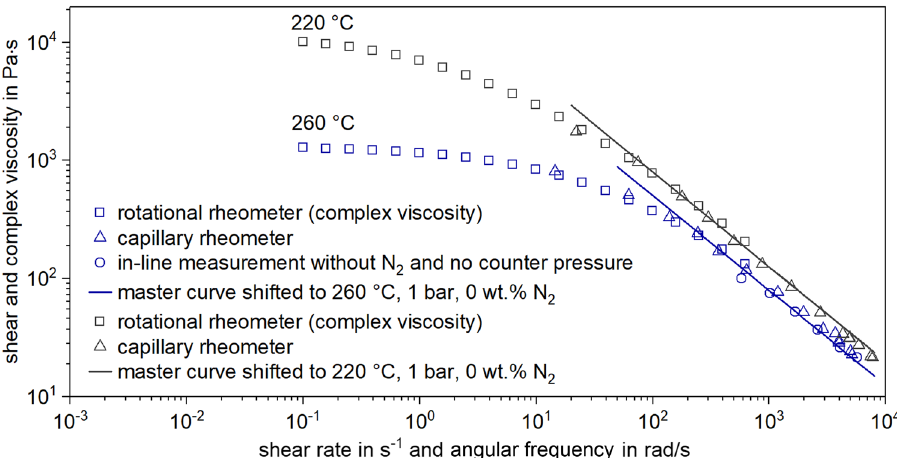
Figure 9: Validation of in - line viscosity measurements and superposition principles for PS.